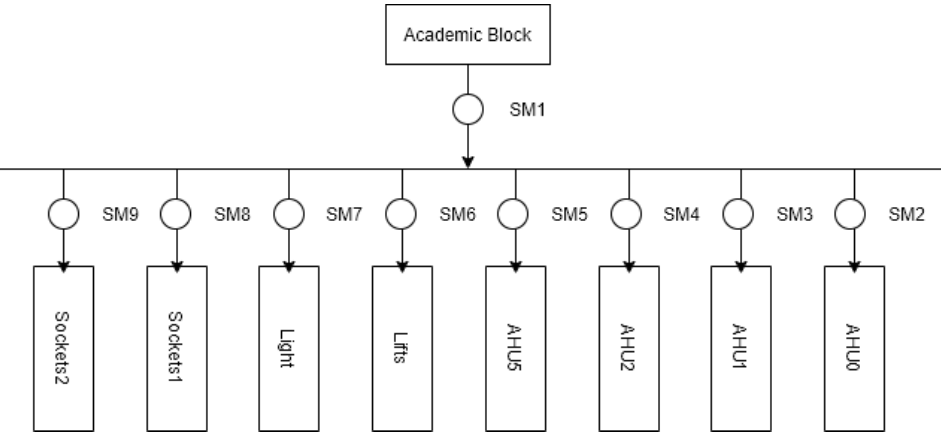
Figure 5. Academic Block’s smart meter installation location instructions. Table 2. Attribute information for electrical load data collected from the Academic